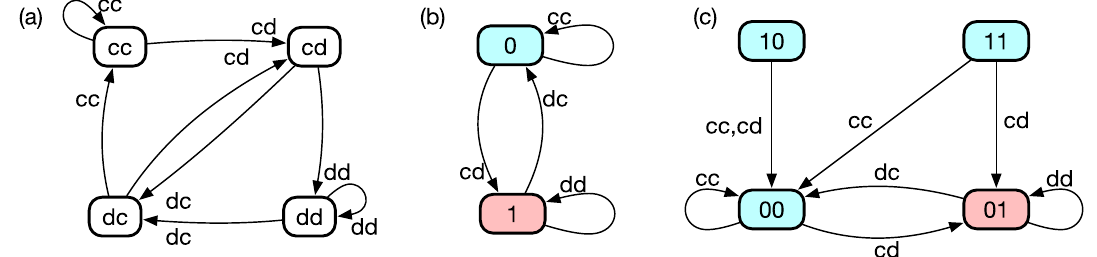
Figure 1. ( a ) Transition among history profiles of TFT. Each node is labelled by a history profile, which is a 2-tuple composed of the last actions of the two players in this memory-one strategy. A history profile may also be regarded as an internal state of the focal player in this naive representation. Each node has two outgoing links because it has two possible destinations depending on the co-player’s choice between c and d . ( b ) State-based representation of TFT with two internal states. If the co-player cooperates (defects), the internal state becomes 0(1), and the focal player chooses an action based on this state. The colour of each node indicates the action prescribed at each state: Blue and red mean cooperation and defection, respectively. ( c ) Graph representation of CTFT, one of the most well-known strategies based on internal states called standing. Each player’s standing is either good (0) or bad (1) from the focal player’s viewpoint. For example, ‘01’ means that the focal player assigns good standing to herself and bad standing to her